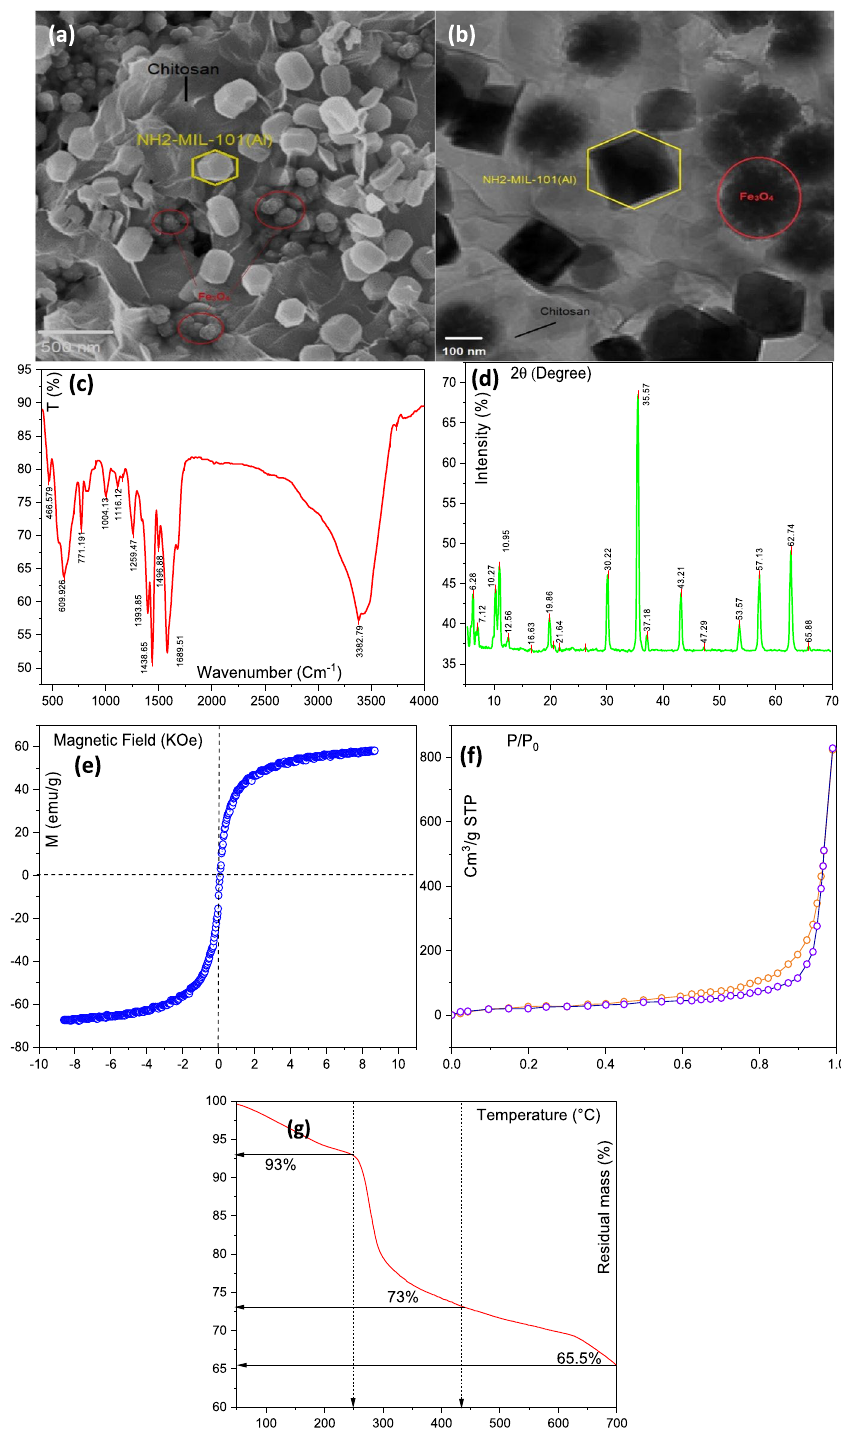
Figure 1. SEM ( a ), TEM ( b ), FTIR ( c ), XRD ( d ), VSM ( e ), BET ( f ) and TGA ( g ) analysis of MIL/Cs@Fe 3 O 4